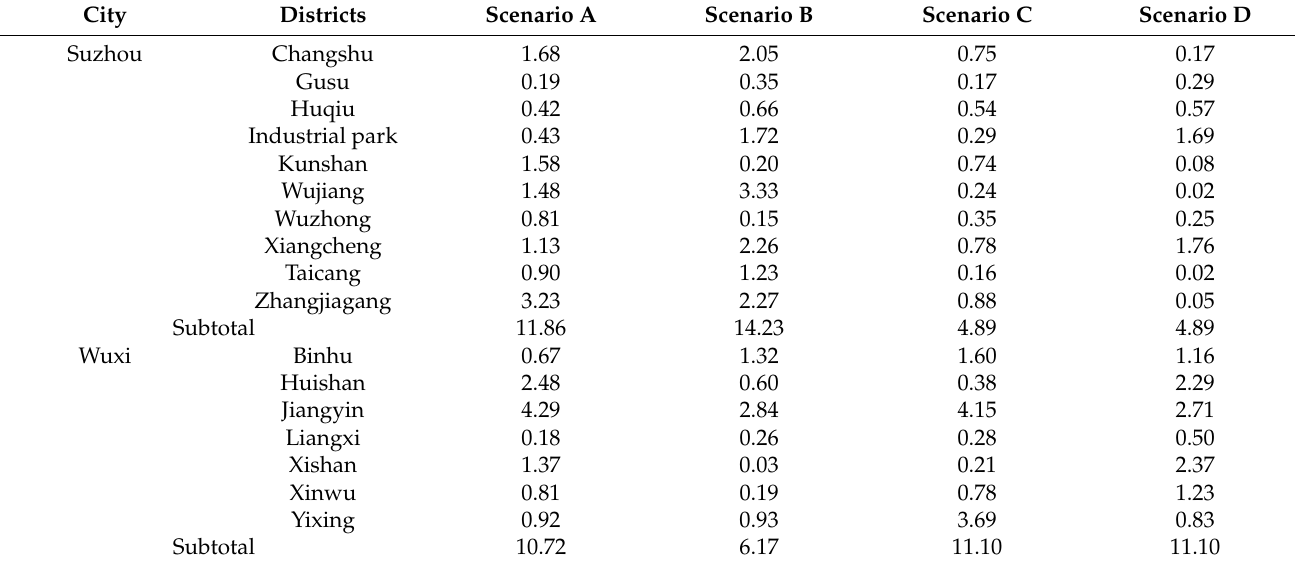
Figure 8. ( a ) Scenario A, ( b ) Scenario B, ( c ) Scenario C, ( d ) Scenario D. Simulation results of urban expansion based on the FLUS model and maps show the spatial distribution of newly added urban land in Scenario A, B, C, and D. Some of the obvious differences are marked by rectangular boxes. Table 3. Calculation results of the land amount that can be allotted to urban expansion planning in each city and district based on the removed rural/industrial land encroaching on GENs (km 2 ). City Districts Scenario A Scenario B Scenario C Scenario